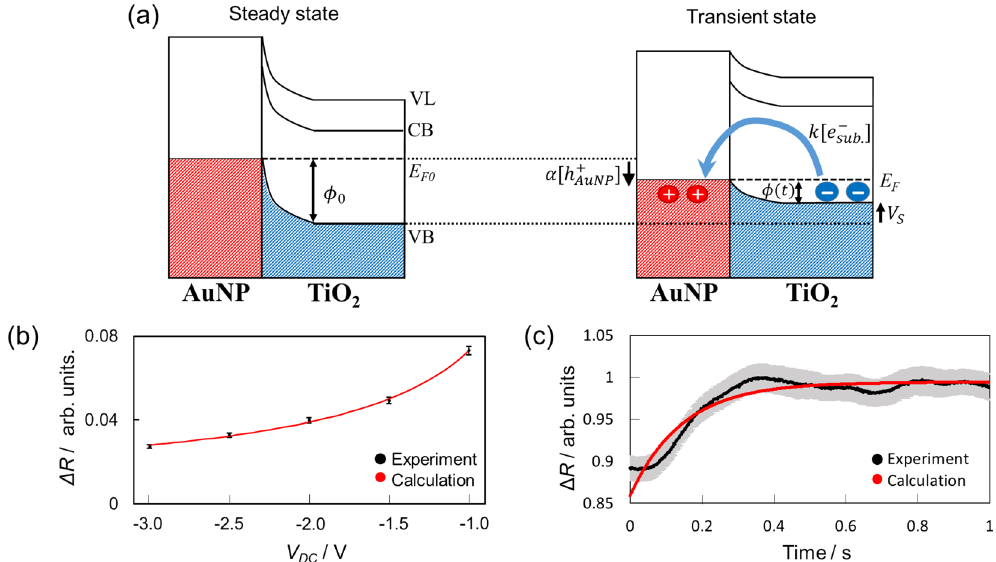
h + . (left) Energy level diagram of the Au AuNP h + (cid:30) (cid:31) AuNP (cid:30) after the laser was switched off with V s . CB: TiO 2 conduction band; VL: vacuum level; E F : Fermi level. ( b ) Δ R as (cid:31)